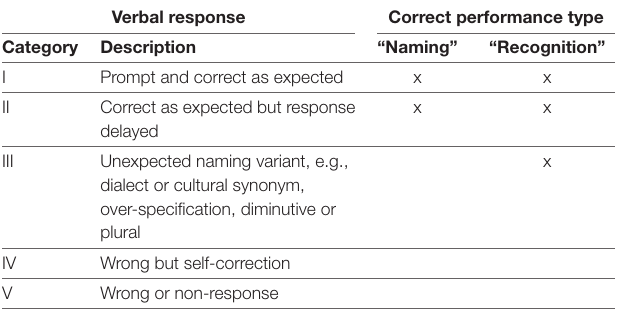
TABLE 3 | Verbal response